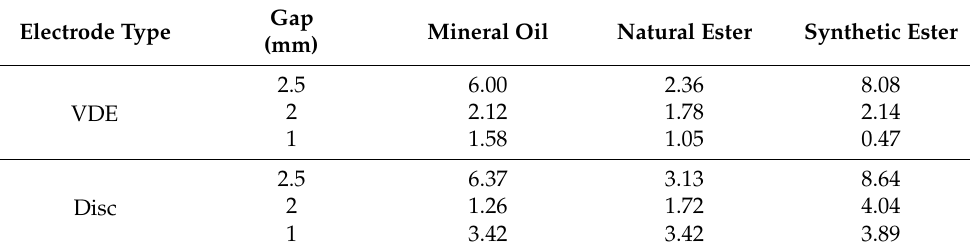
Table 8. Standard deviations for negative DC BDV test results.